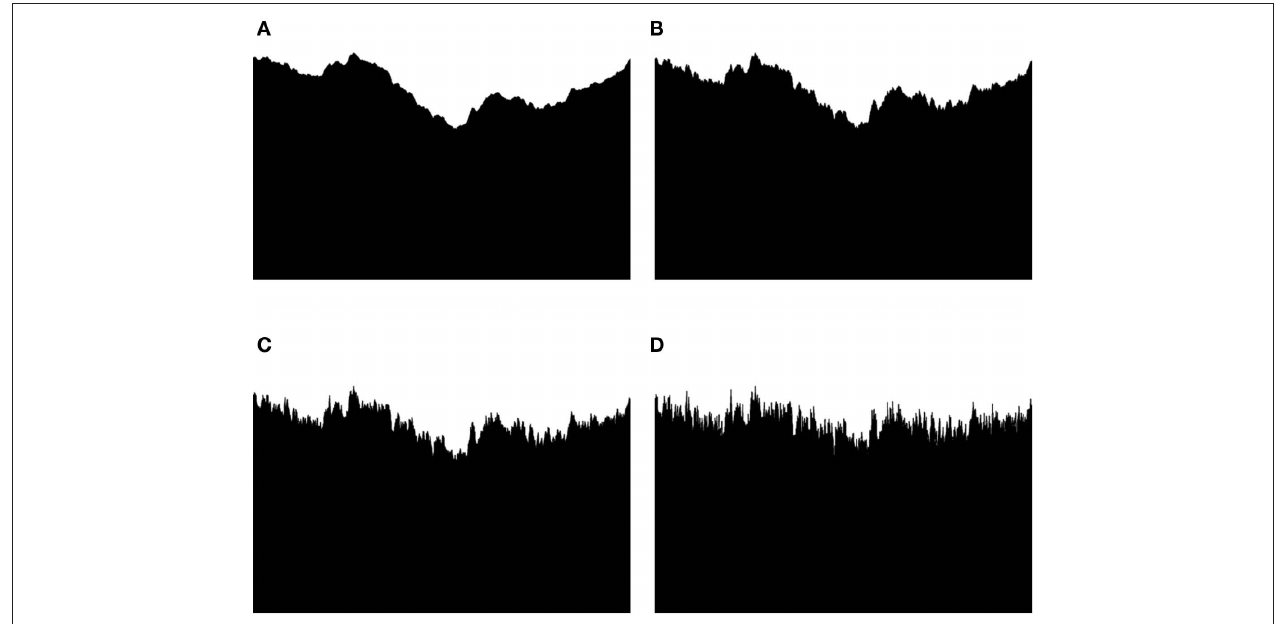
FiGurE 10 | The fractal skylines used in the qEEG study. The fractal dimensions of the images were as follows: D (A) 1.14 (B) 1.32 (C) 1.51 and